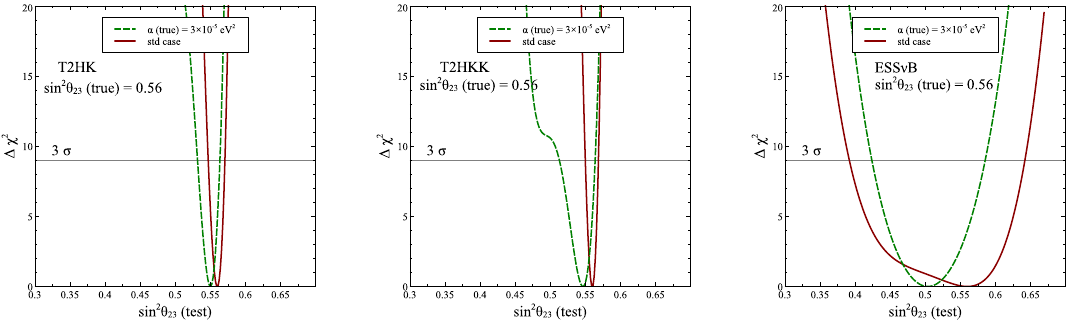
Figure 9 . The ∆ χ 2 as a function of θ 23 (test) assuming sin 2 θ 23 (true) = 0 . 56 . The left, middle and the right panels are for T2HK, T2HKK and ESS ν SB respectively. The dark red solid curves are for standard cases and the green dashed curves are for the cases where α is assumed to be 3 × 10 − 5 eV 2 in the simulated data but decay is not considered in the